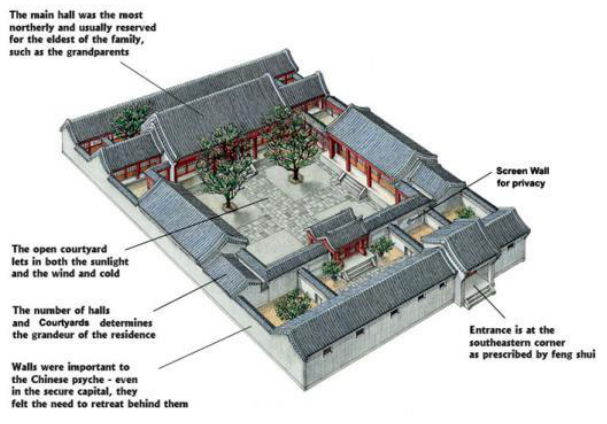
Figure 2. A standard/typical Ming (1368-1644) or Qing (1644- 1911) Beijing courtyard house ( siheyuan ) with three yards: front, central, and back. The central courtyard is where most family activities would take place. Source: chinaspree.com, 2014.